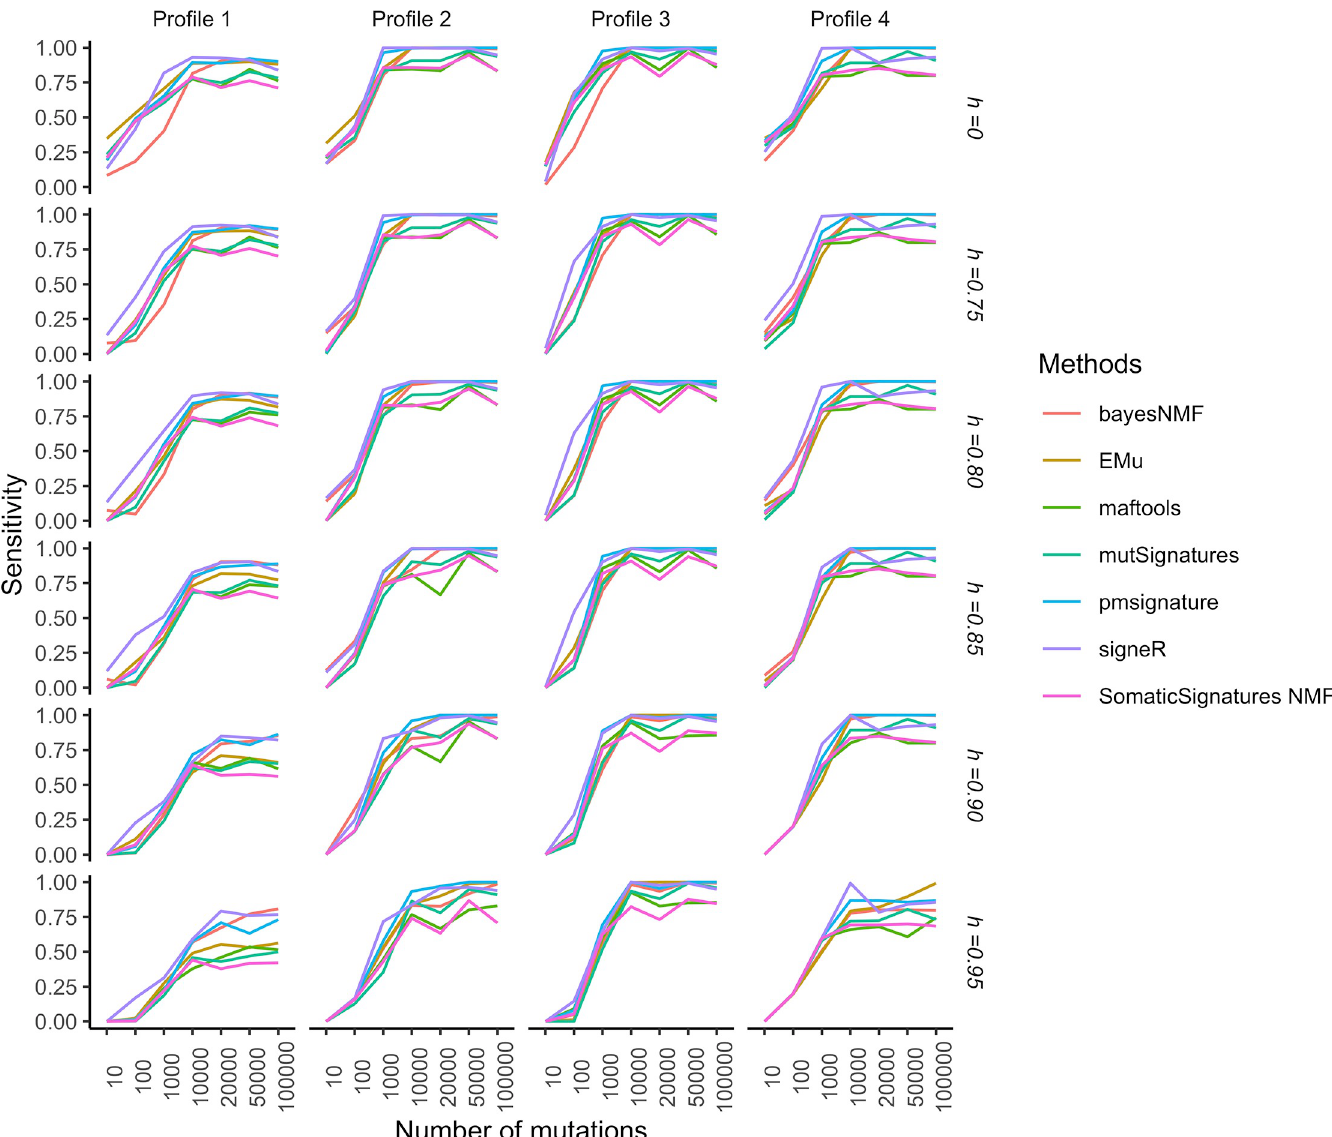
Fig 7. Simulation study: Sensitivity of extraction methods and mapping on COSMIC signatures as the average number of mutations and the cosine cut-off h vary. Sensitivity is estimated from 50 replicates each made of G = 30 catalogues. The model used to simulate realistic replicates according to the four Profiles and the estimation methods are described in the section Data and experimental